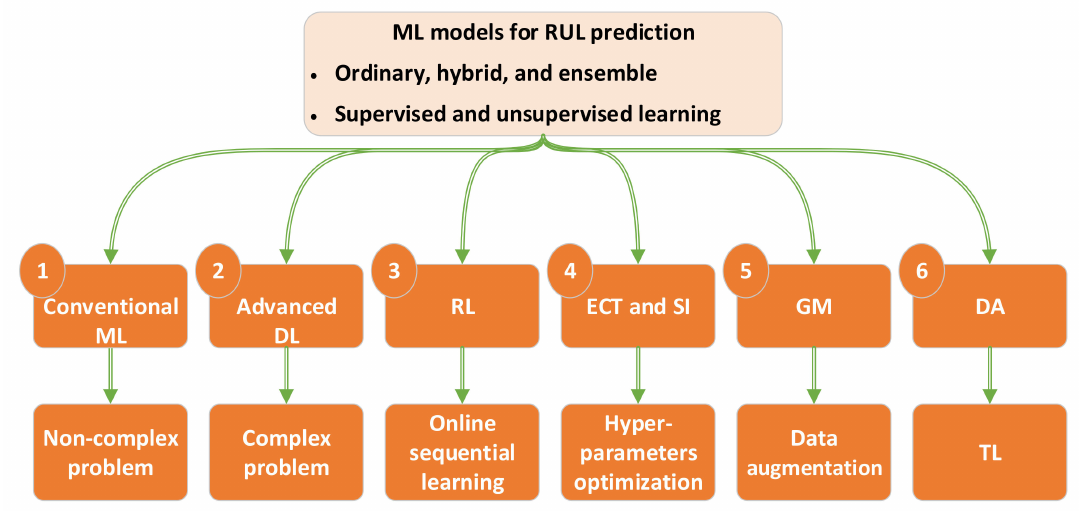
Figure 10. Different classes of ML models for RUL prediction problems.